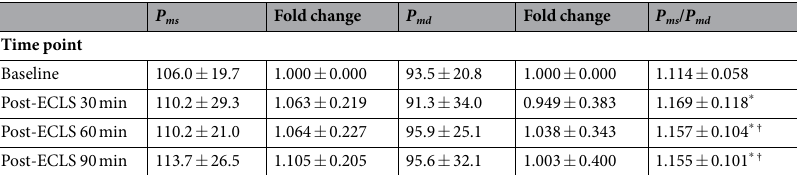
Table 2. Effects of ECLS on the mean systolic and the mean diastolic pressure in rats at baseline and at 30, 60, and 90 min post-ECLS. Variables are expressed as median ± interquartile range (IQR). P ms = mean systolic pressure (mmHg); P md = mean diastolic pressure (mmHg). * P < 0.05 compared with baseline. † P < 0.05 compared with post-ECLS 30